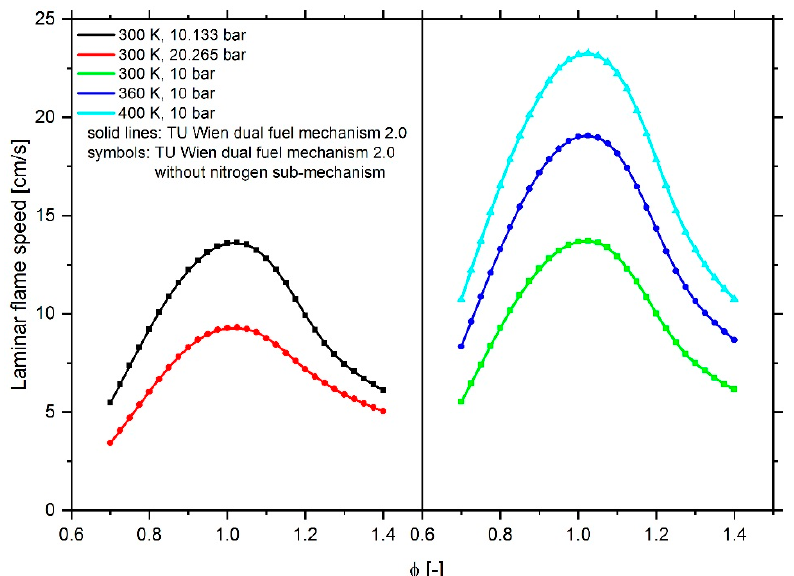
Figure 25. Simulated laminar flame speed values as function of the fuel–air equivalence ratio φ using the TU Wien dual fuel mechanism 2.0 (lines) and the TU Wien dual fuel mechanism 2.0 without the nitrogen sub-mechanism (symbols).